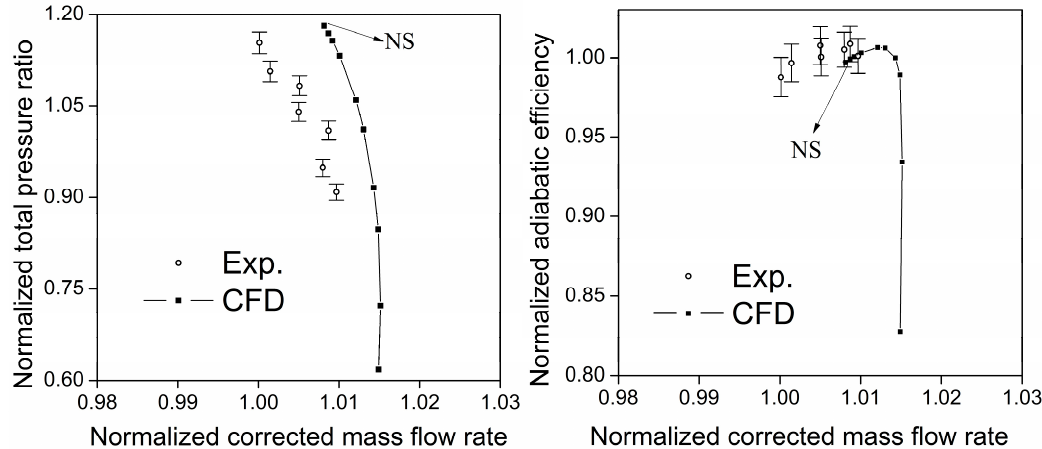
Figure 4. Measured and predicted overall performance. NS: Near Stall.